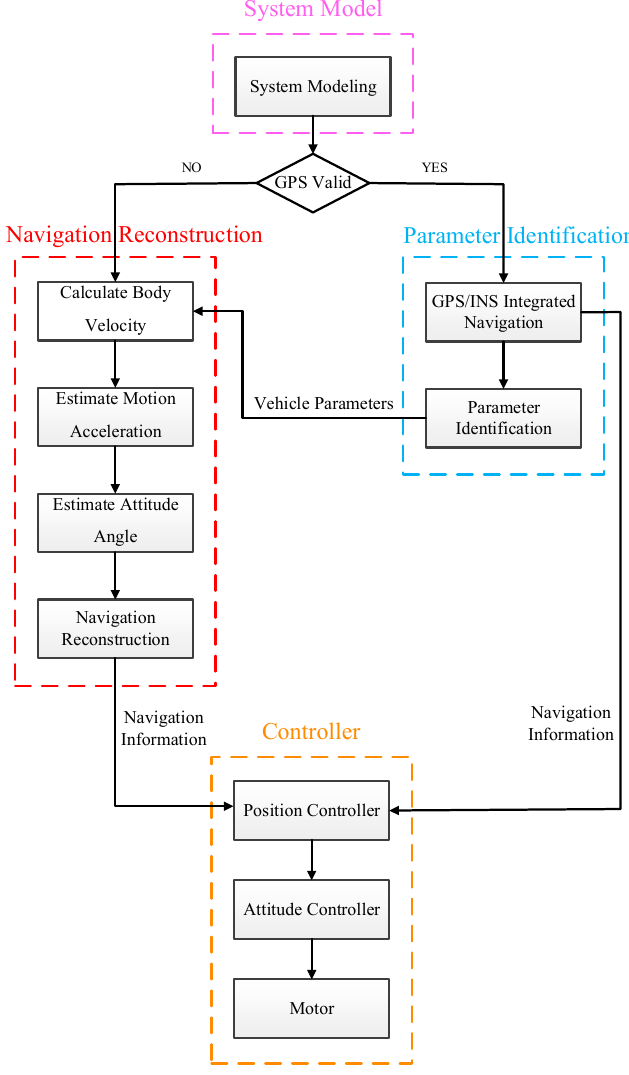
Figure 1. The flow diagram of the navigation reconstruction